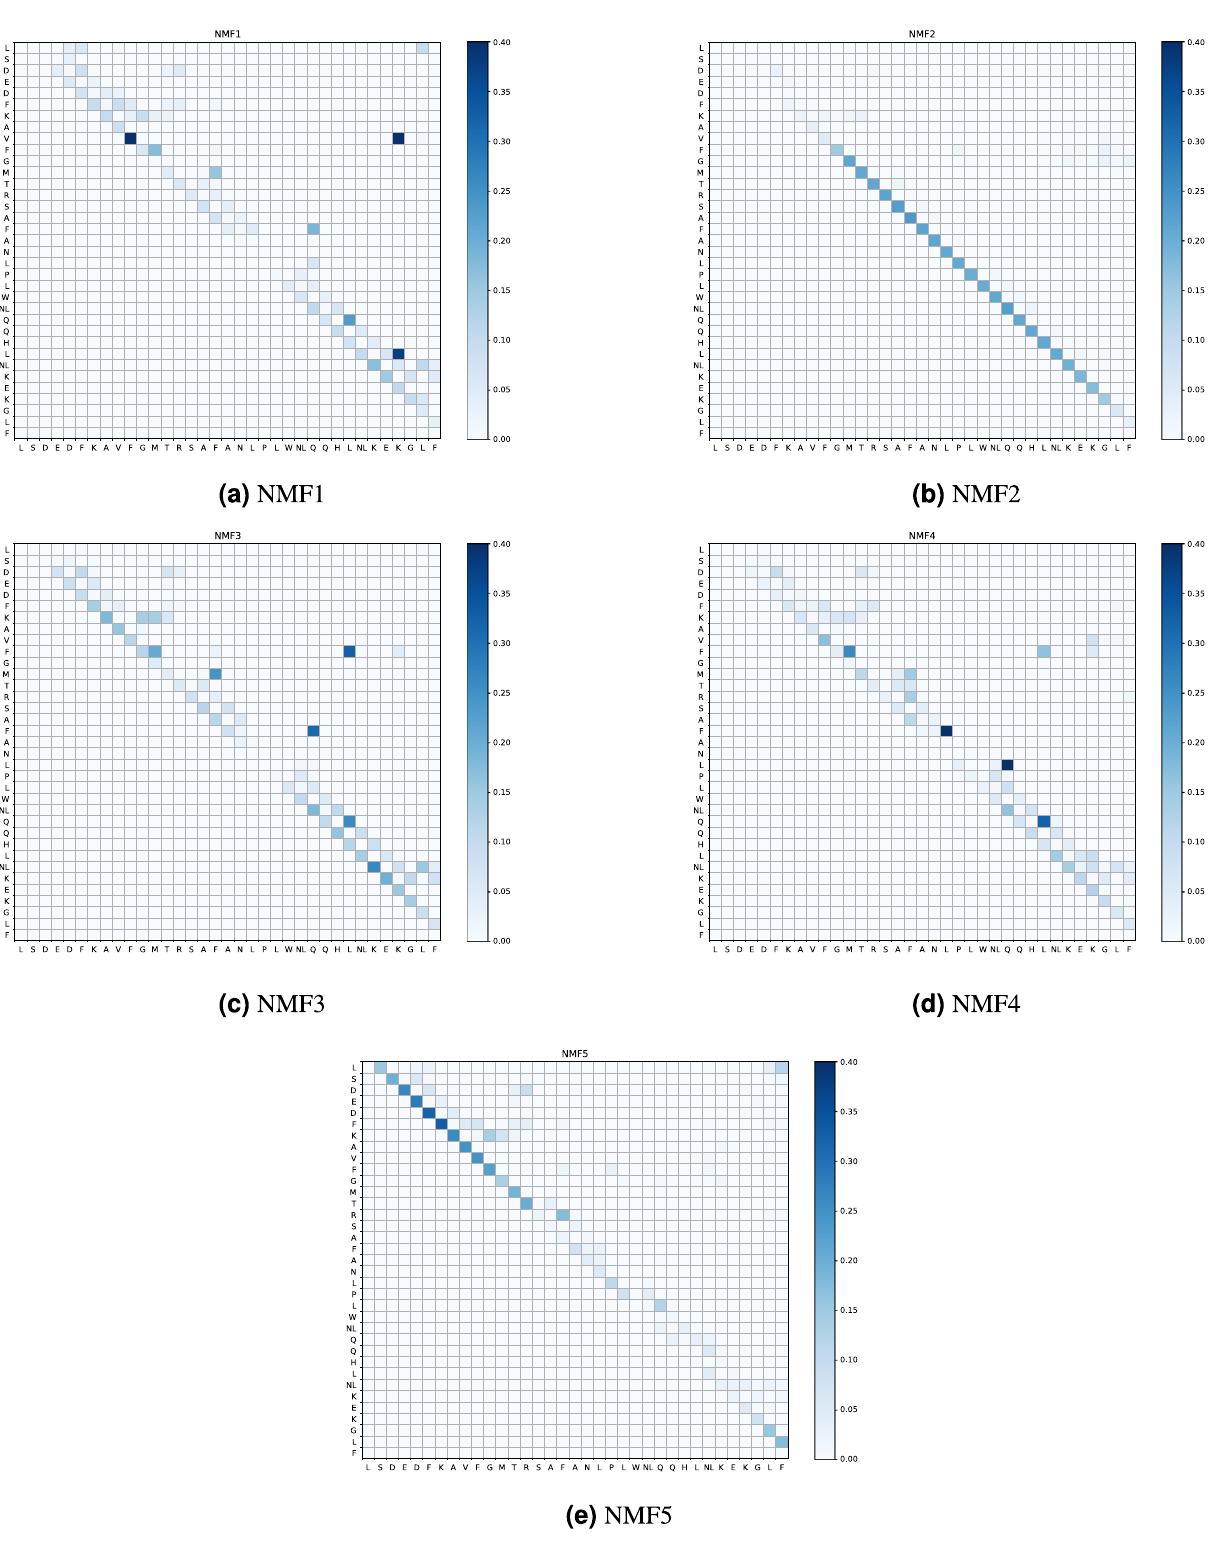
Figure 6. Basis of non-negative matrix factorization(NMF). Darker cells indicate that the basis has a large component in this